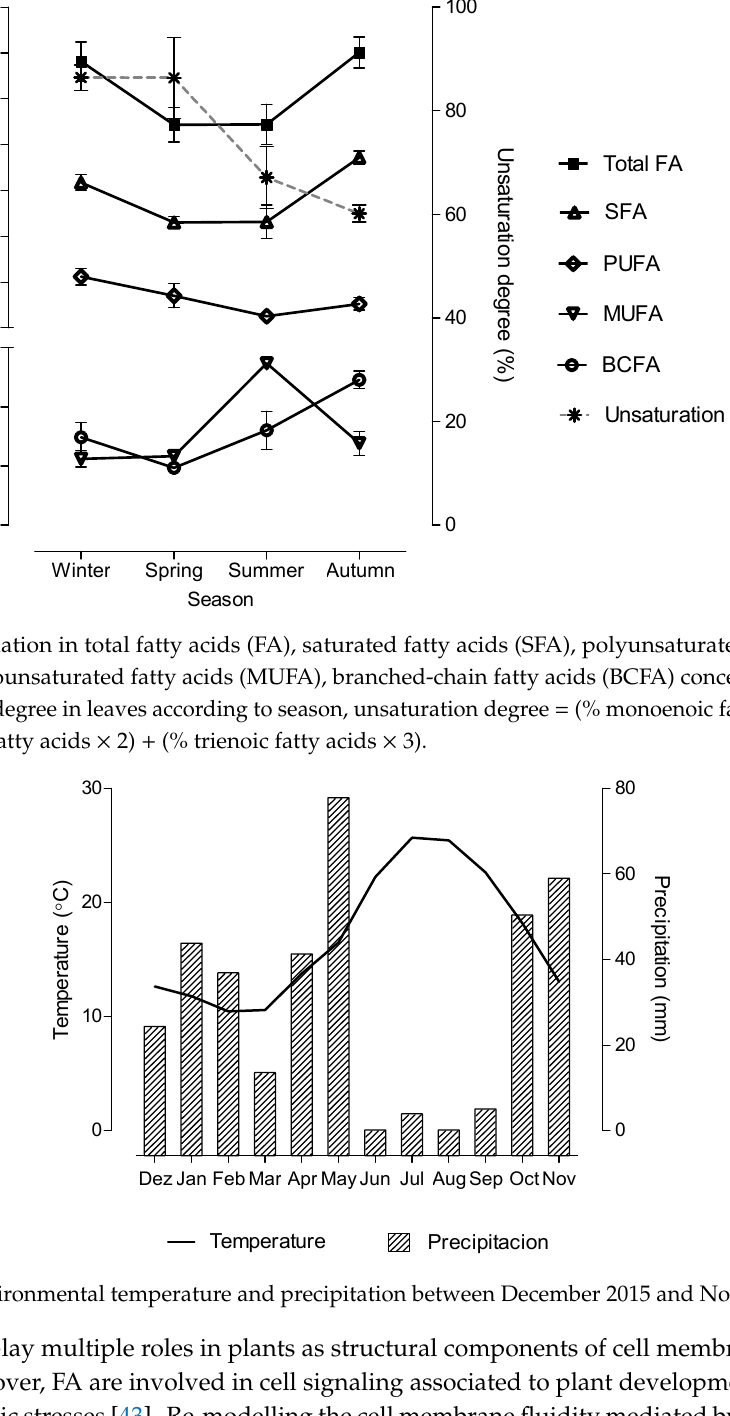
Figure 6. A sampling of several C. ladanifer morphological fractions throughout the year.